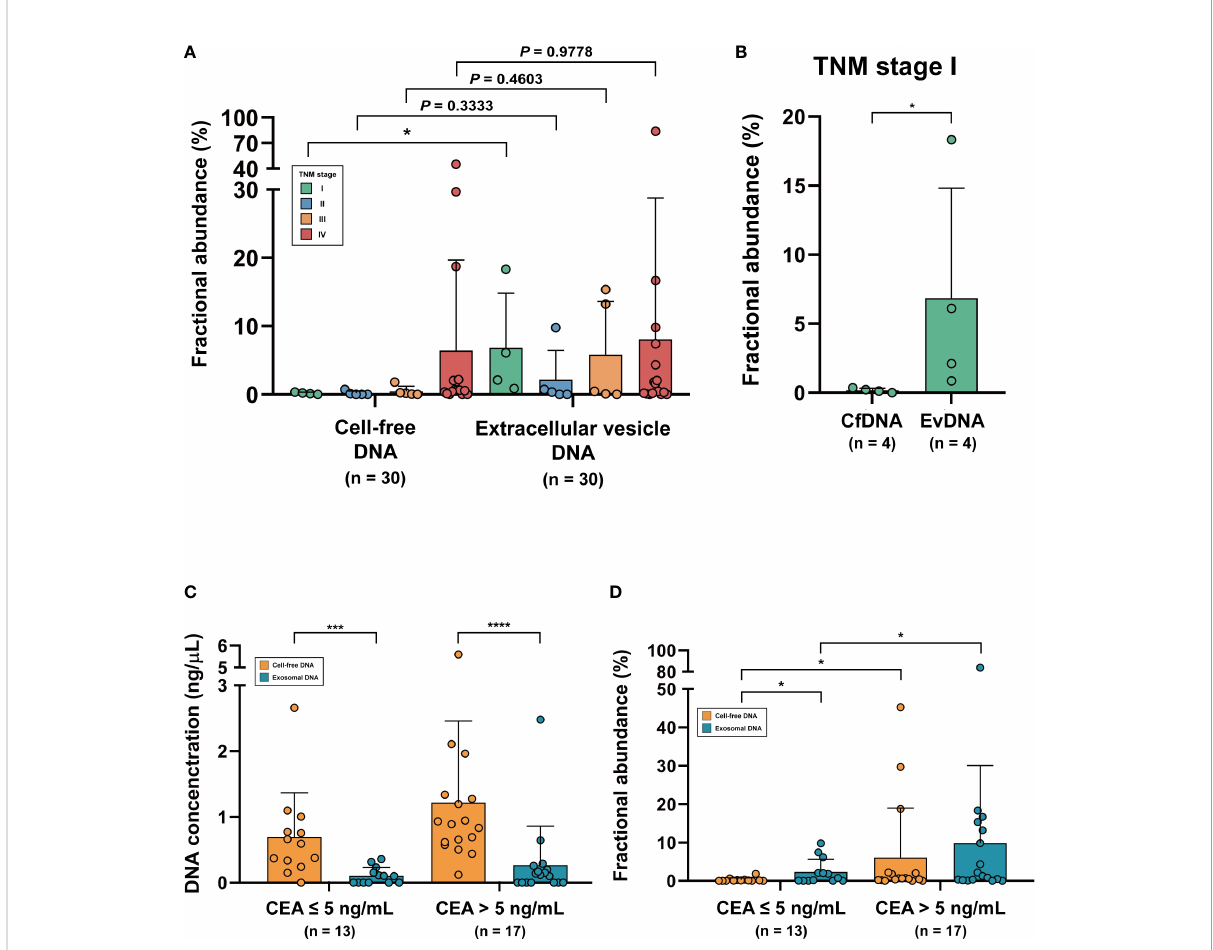
FIGURE 3 Representation of patients ’ clinical status in cell-free DNA and extracellular vesicle DNA. (A) Fractional abundance of cell-free DNA and extracellular vesicle DNA compared with TNM stage. (B) Fractional abundance of cell-free DNA and extracellular vesicle DNA in TNM stage (I) * P < 0.05. (C) Comparison of DNA concentration of cell-free DNA and extracellular vesicle DNA in CEA-low and CEA-high groups. *** P < 0.001, ****P < 0.0001. (D) Comparison of fractional abundance of cell-free DNA and extracellular vesicle DNA in CEA-low and CEA-high groups. * P <